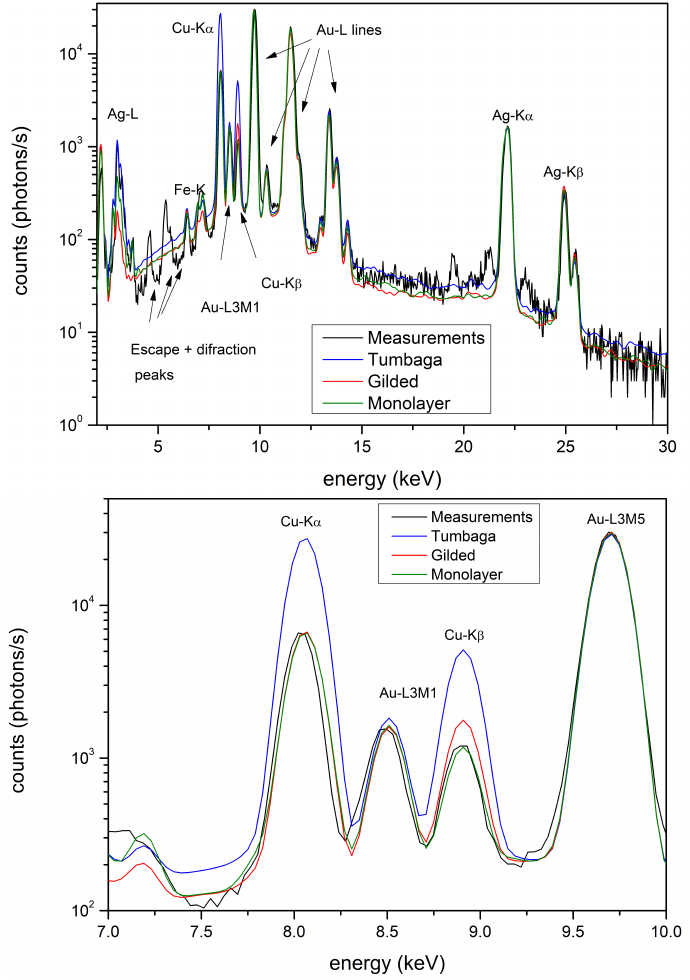
Figure 9. Nose protector: Comparison between the EDXRF-measured spectrum and that simulated by MCS for Tumbaga , Au alloy and gilded copper . In the figure at the bottom the peak structure in the 7–10 keV range is depicted. It is clearly visible the effect of the different model on the quality of the